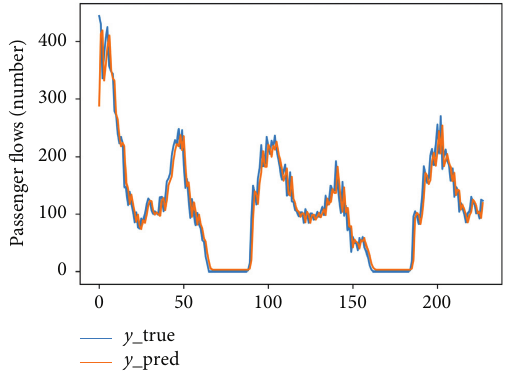
Figure 15: Regression integration prediction results when the time step is 30 min.